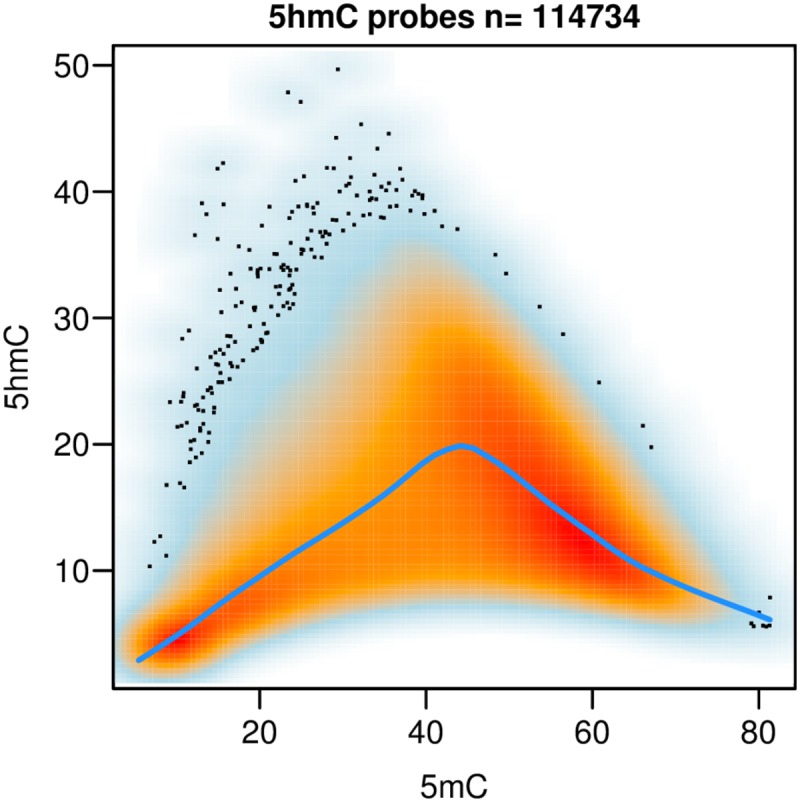
Scatter plot of 5hmC vs 5mC.5hmC levels are highest at intermediate levels of 5mC (~40%).